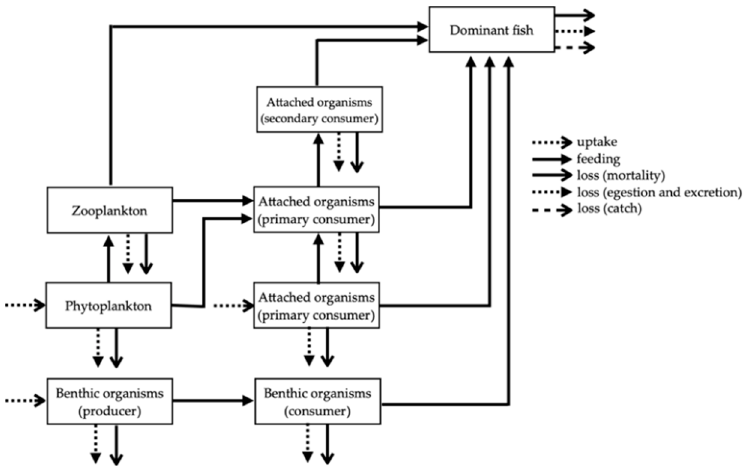
Figure 2. Simplified framework for predator–prey relationships in artificial timber reefs and bare seafloor areas . Table 1. Mass balance equations for the compartments used in the present numerical model . Symbols